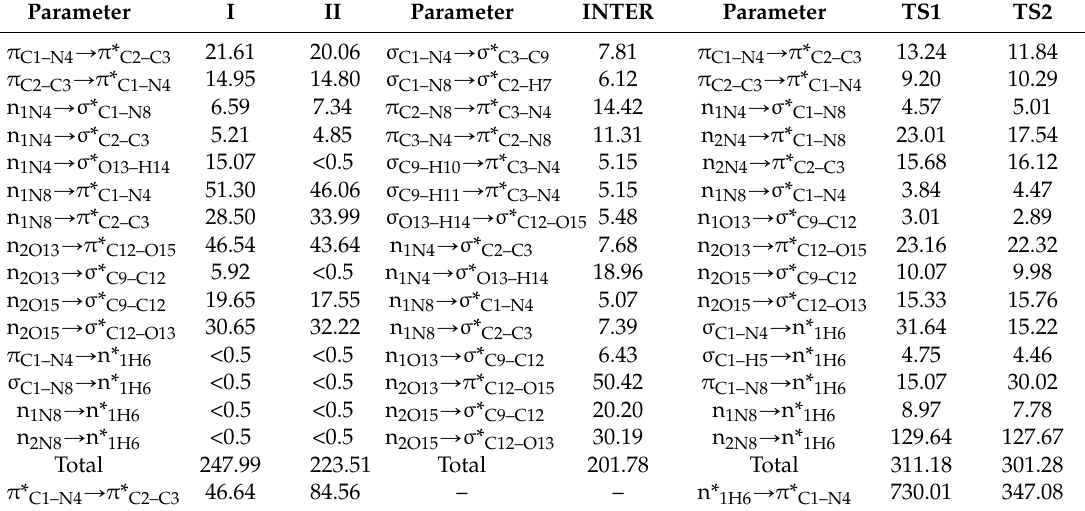
Table 7. Second order perturbation ( E (2) ) estimation of the hyperconjugative energies (kcal/mol) of hydrogen bonded imidazole-4-acetic acid (I), the transition states (TS1 and TS2), the intermediate (INTER) and imidazole-5-acetic acid (II) which were calculated using B3LYP/6-311++G** level of